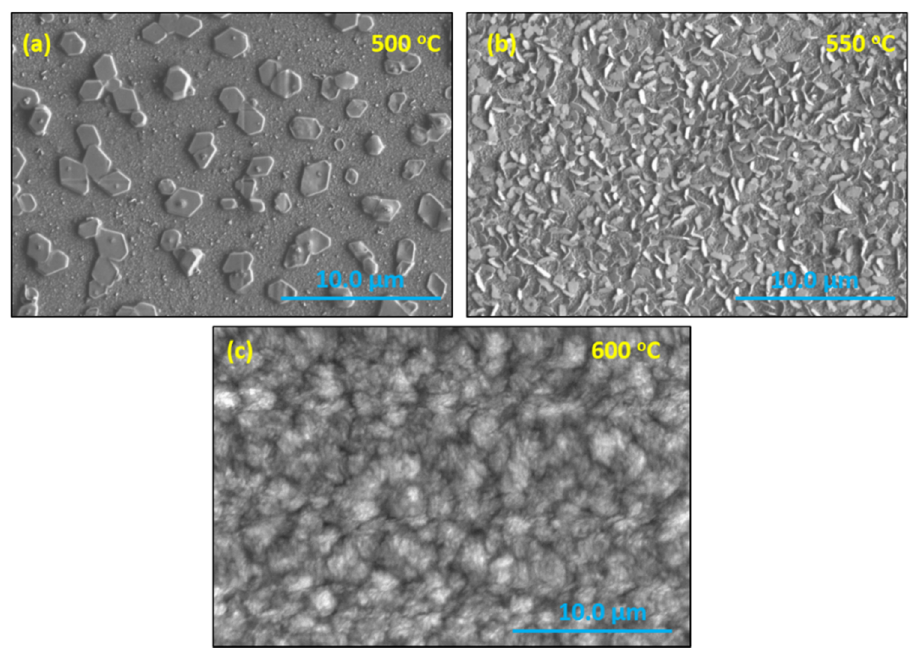
Figure 2: FESEM micrographs of Tl 2 S thin fi lms deposited on FTO substrate via AACVD technique at three di ff erent temperatures: ( a ) 500°C, ( b ) 550°C, and ( c ) 600°C.